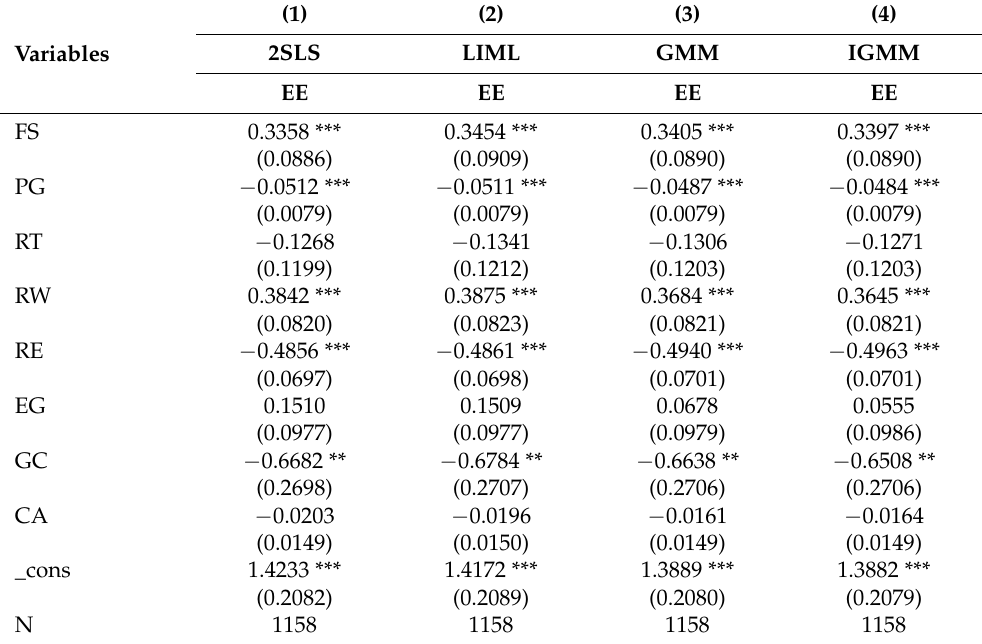
Table 4. The empirical results on endogeneity tests for